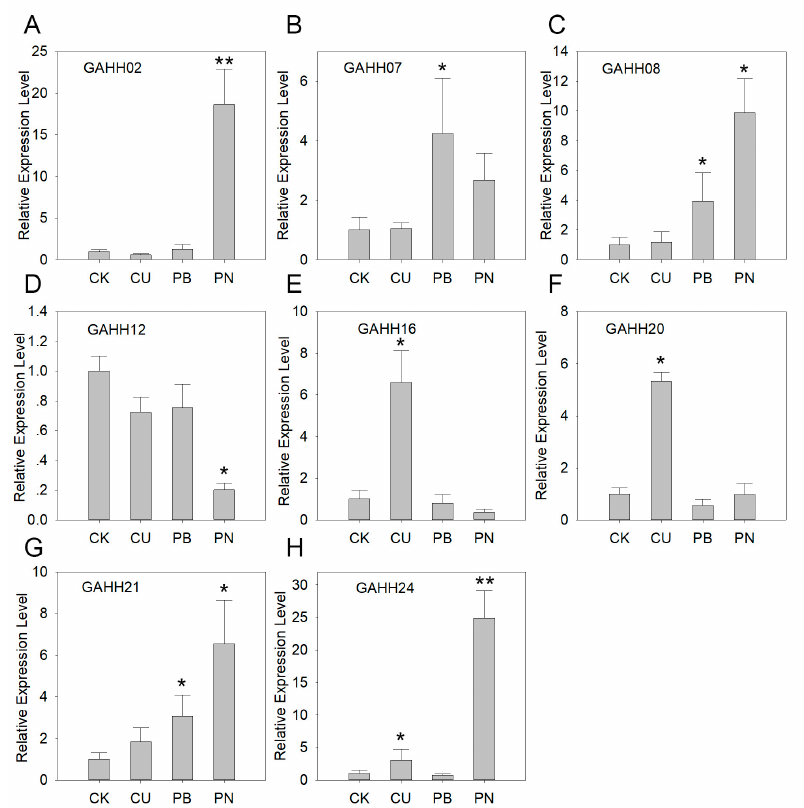
Figure 4. Expression patterns of GAHH02 ( A ), GAHH07 ( B ), GAHH08 ( C ), GAHH12 ( D ), GAHH16 ( E ), GAHH20 ( F ), GAHH21 ( G ). and GAHH24 ( H ) under abiotic (Cu and Pb) and biotic ( Phytophthora nicotianae Breda) stresses in A. H11648 by qRT-PCR. Y -axis represents relative expression level. CK, CU, PB and PN of x -axis represent control, CuSO 4 treatment, Pb(NO 3 ) 2 treatment and Phytophthora nicotianae Breda inoculation, respectively. The error bar represents the standard error. * and ** represent that expression level was higher or lower expressed by more than 3-fold and 10-fold, respectively (compared with control).